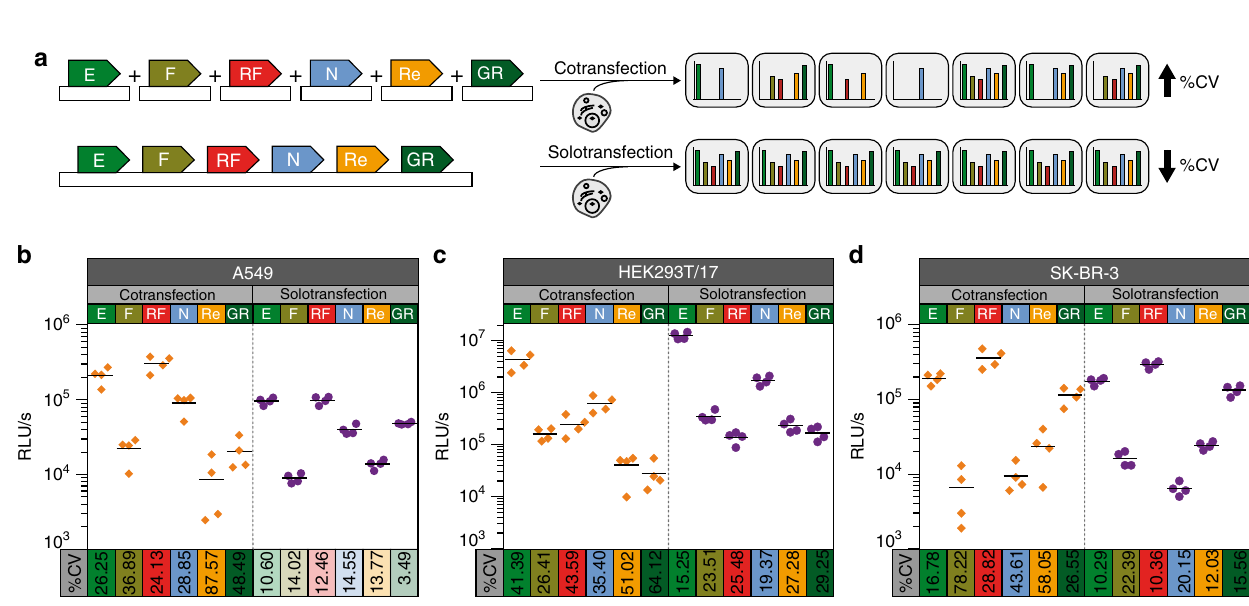
Fig. 4 Solotransfection of a single multi-luciferase reporter vector results in lower experimental variability than cotransfection of six individual luciferase reporters. a Schematic illustrating cellular uptake and variability issues likely encountered during cotransfection of six individual plasmids each encoding a single luciferase transcriptional unit (Top). These effects are not observed with solotransfection of a single plasmid encoding all six luciferase transcriptional units (Bottom). Equivalent cellular uptake of all luciferase units and a lower coef fi cient of variation (%CV) were observed with solotransfection, but not with cotransfection. b – d Variability in the quanti fi cation of the different luciferases following cotransfection (Left) or solotransfection (Right). The absolute luminescence in relative luminescence units per second (RLU/s) of four biological replicates, measured as previously described (Fig. 1i and Supplementary Fig. 7), is represented on the y-axis, while the %CV between replicates is indicated on the x -axis for A549 b , HEK293T/17 c , and SK-BR-3 d cells. A lower %CV was observed during solotransfection, compared to cotransfection, for all luciferase measurements in all three cell lines. E (ELuc), F (FLuc), RF (RedF), N (NLuc), Re (Renilla), GR (GrRenilla). Four technical replicates are included in each data point; the mean is represented with the horizontal bar. Source data are provided as a Source Data fi did not observe signi fi cant changes in the TGF- β pathway (Fig. 5b, left). These results are consistent with data generated from qPCR CDKN1A , BAX1 , IL6 , BCL-X , CCL2 , and MMP1 were down- did not exhibit any signi fi cant changes in transcript level following siRNA treatment (Fig. 5b, right). These results were corroborated